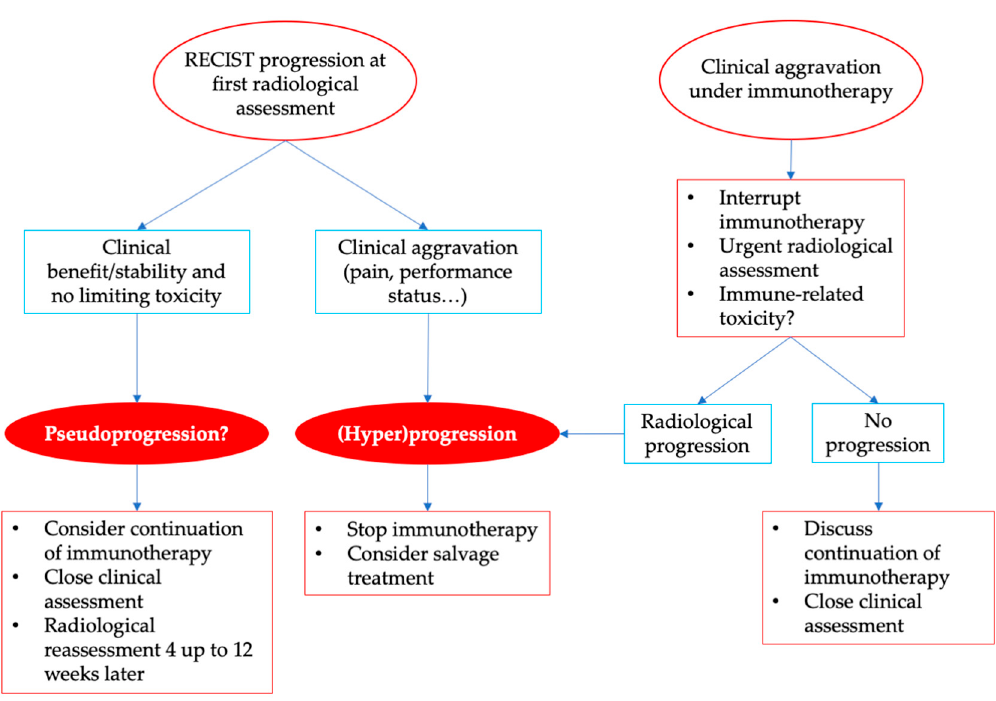
Figure 4. Management of radiological progression and clinical aggravation under immunotherapy.